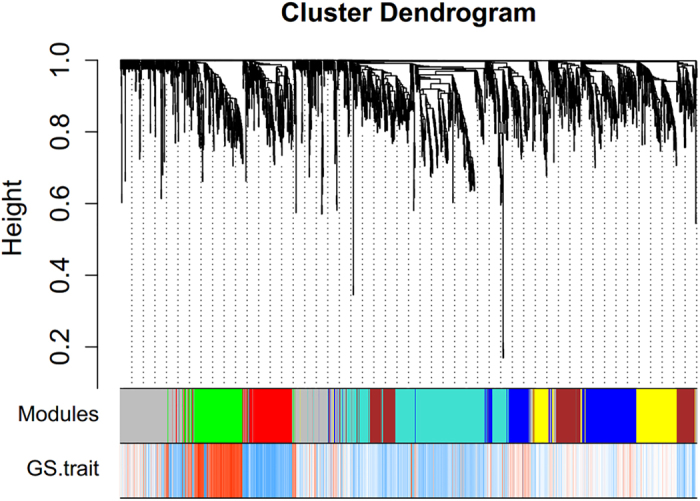
Hierarchical cluster tree of the 2484 genes.The color bands provide a simple visual comparison of module assignments (branch cuttings) based on the dynamic hybrid branch cutting method. The first band shows the results from the automatic single block analysis and the second color band visualizes the gene significance measure: “red” indicates a negative correlation with disease, and “blue” indicates a positive correlation.